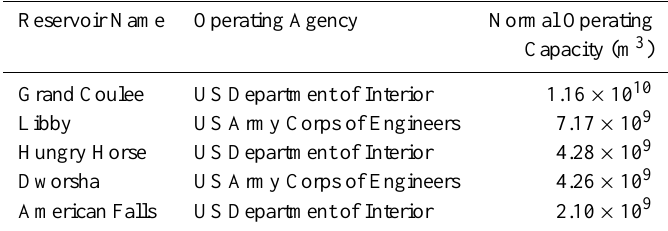
Table A1. The reservoirs used in the GRACE analysis.